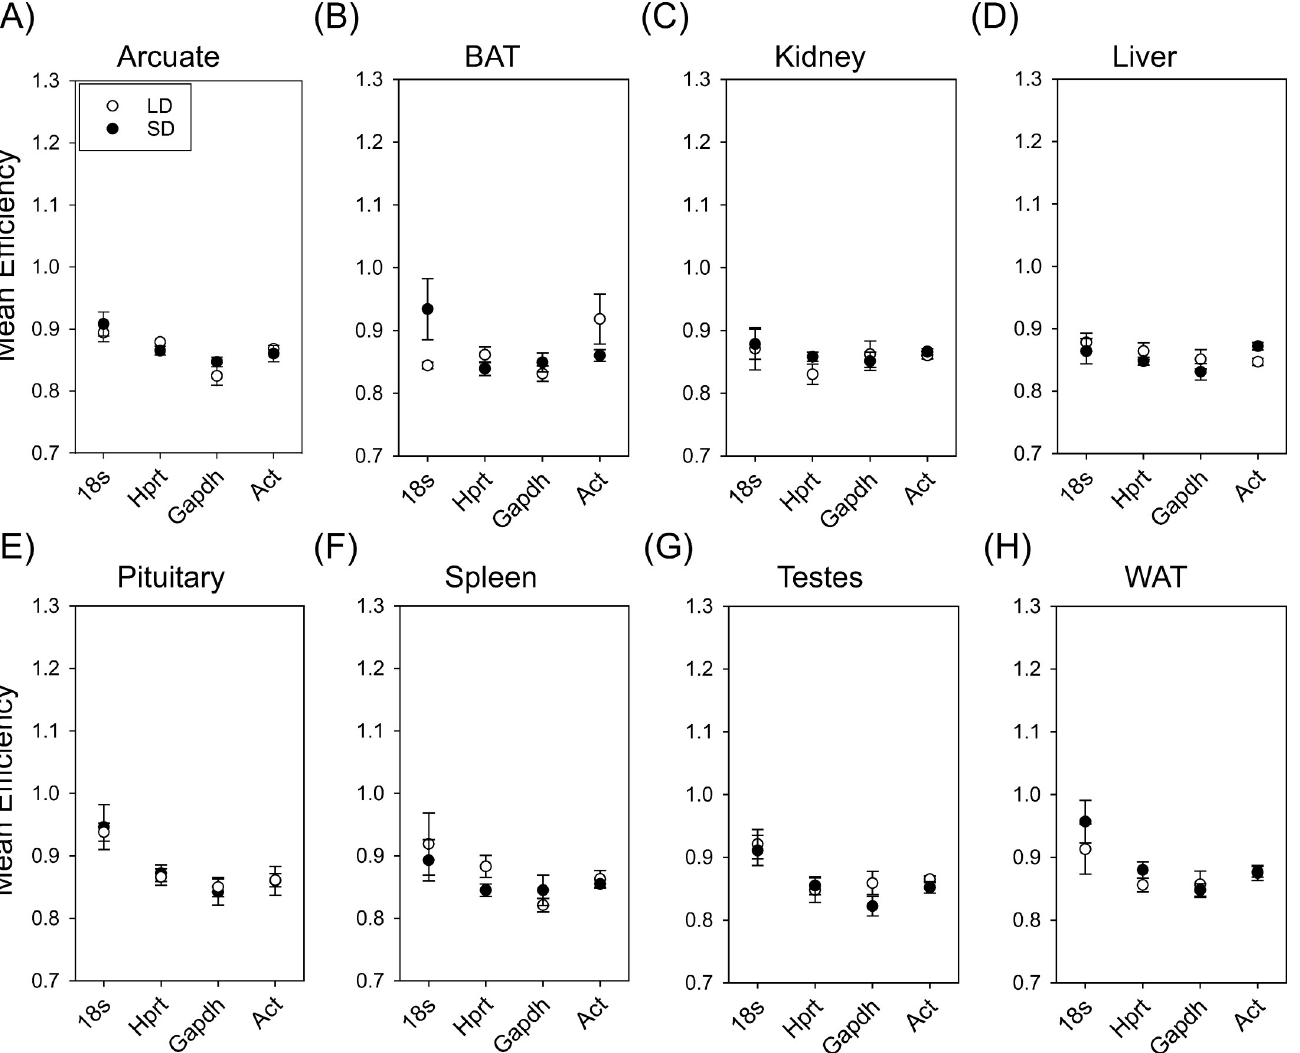
Fig 3. Expression efficiency of 18s, Hprt, Gapdh and Act in hamster tissues across photoperiod conditions. Mean coefficient of variation (CV%) of 18s, Hprt, Gapdh and Act in arcuate (A), BAT (B), kidney (C), liver (D), pituitary (E), spleen (F), testes (G) and Wat (H).